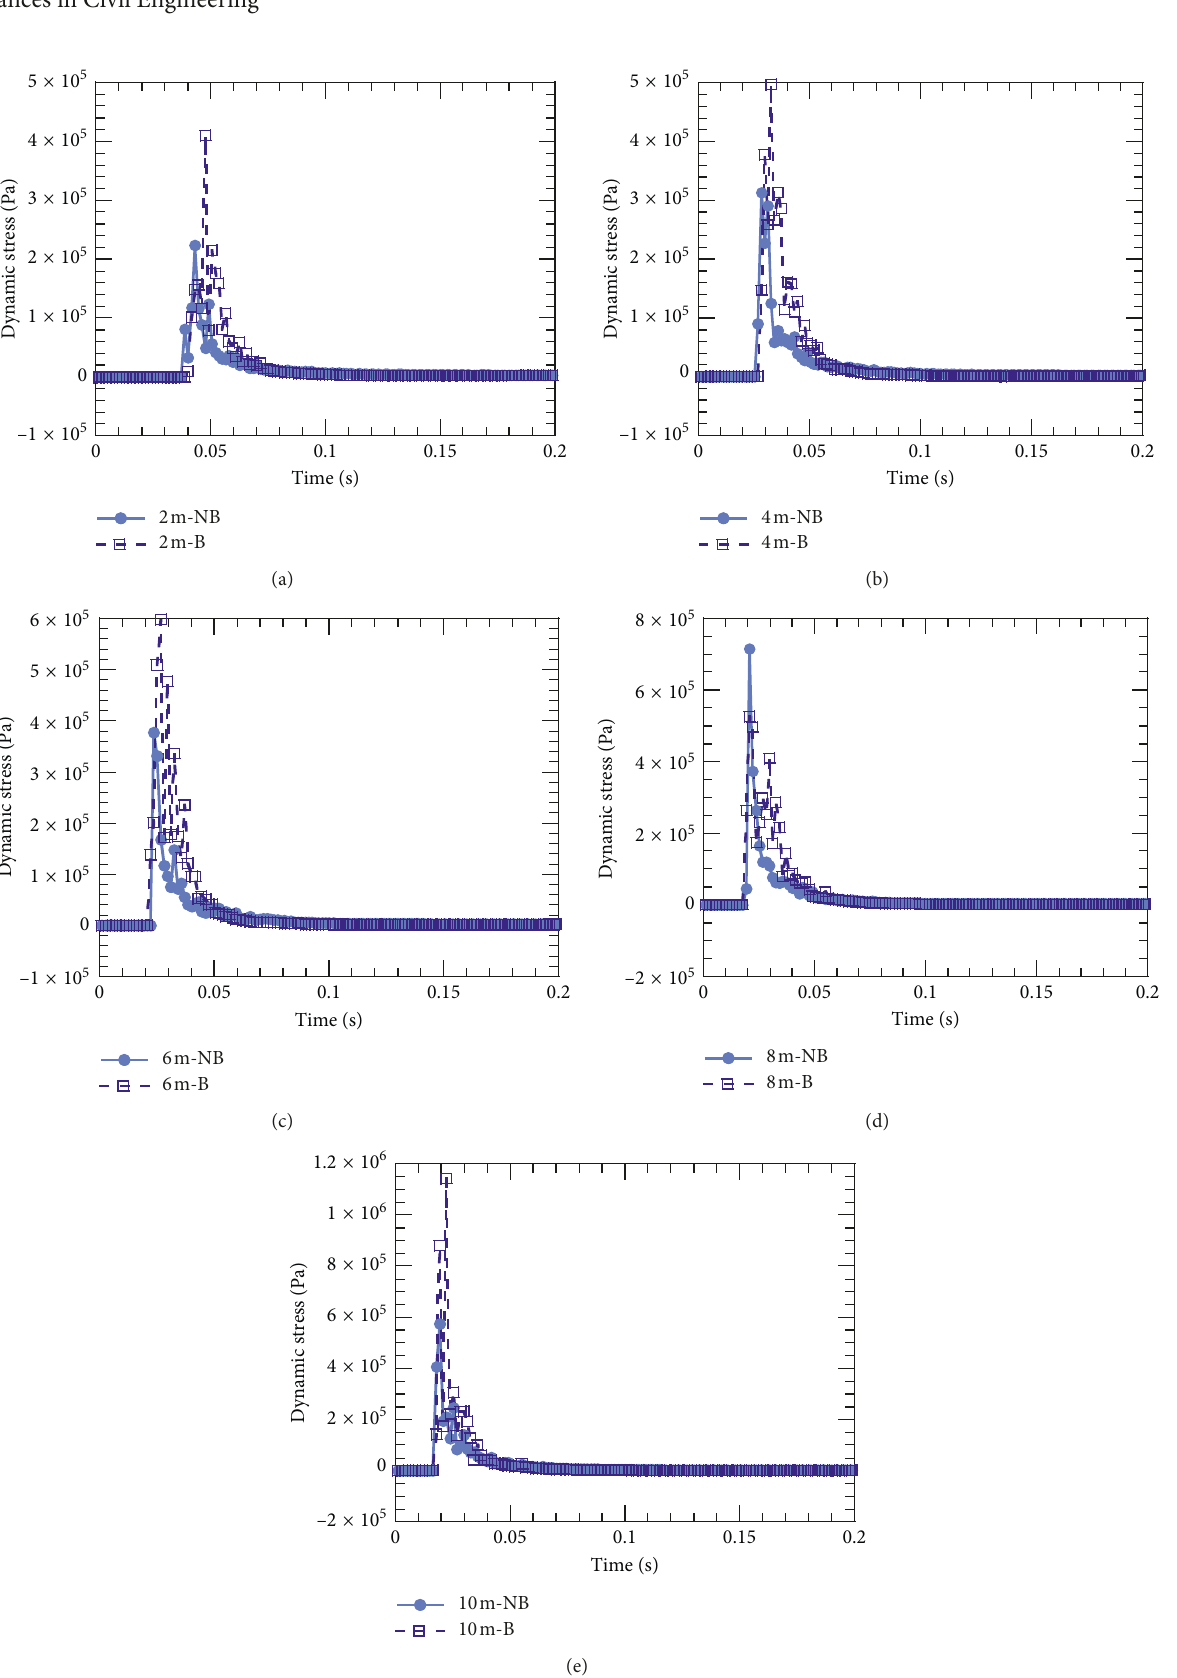
Figure 8: Time history of dynamic stress of tamper bottom (NB means no particle breakage; B means